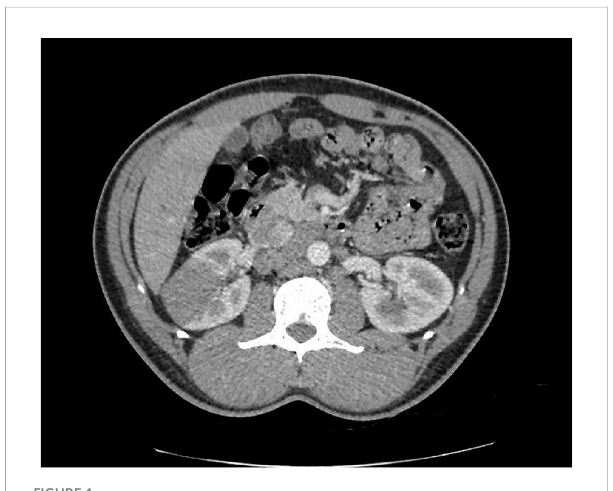
FIGURE 1 Axial enhanced CT scan showing the poorly delimited right renal mass at